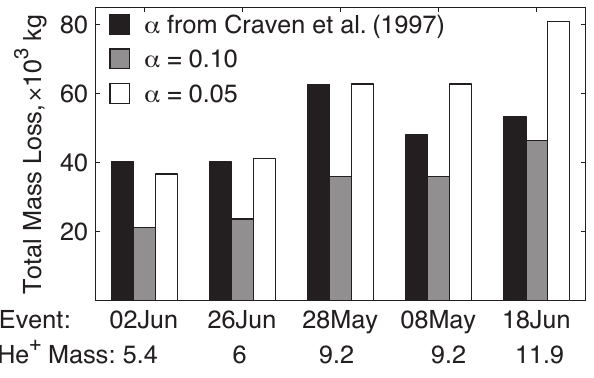
Fig. 8. The total mass of plasma in metric tons removed from the inner magnetosphere for each of the disturbance intervals calculated using two constant density ratios, α = 0 . 10, and α = 0 . 05 and by allowing the ratio to vary as a function of radial distance and solar EUV